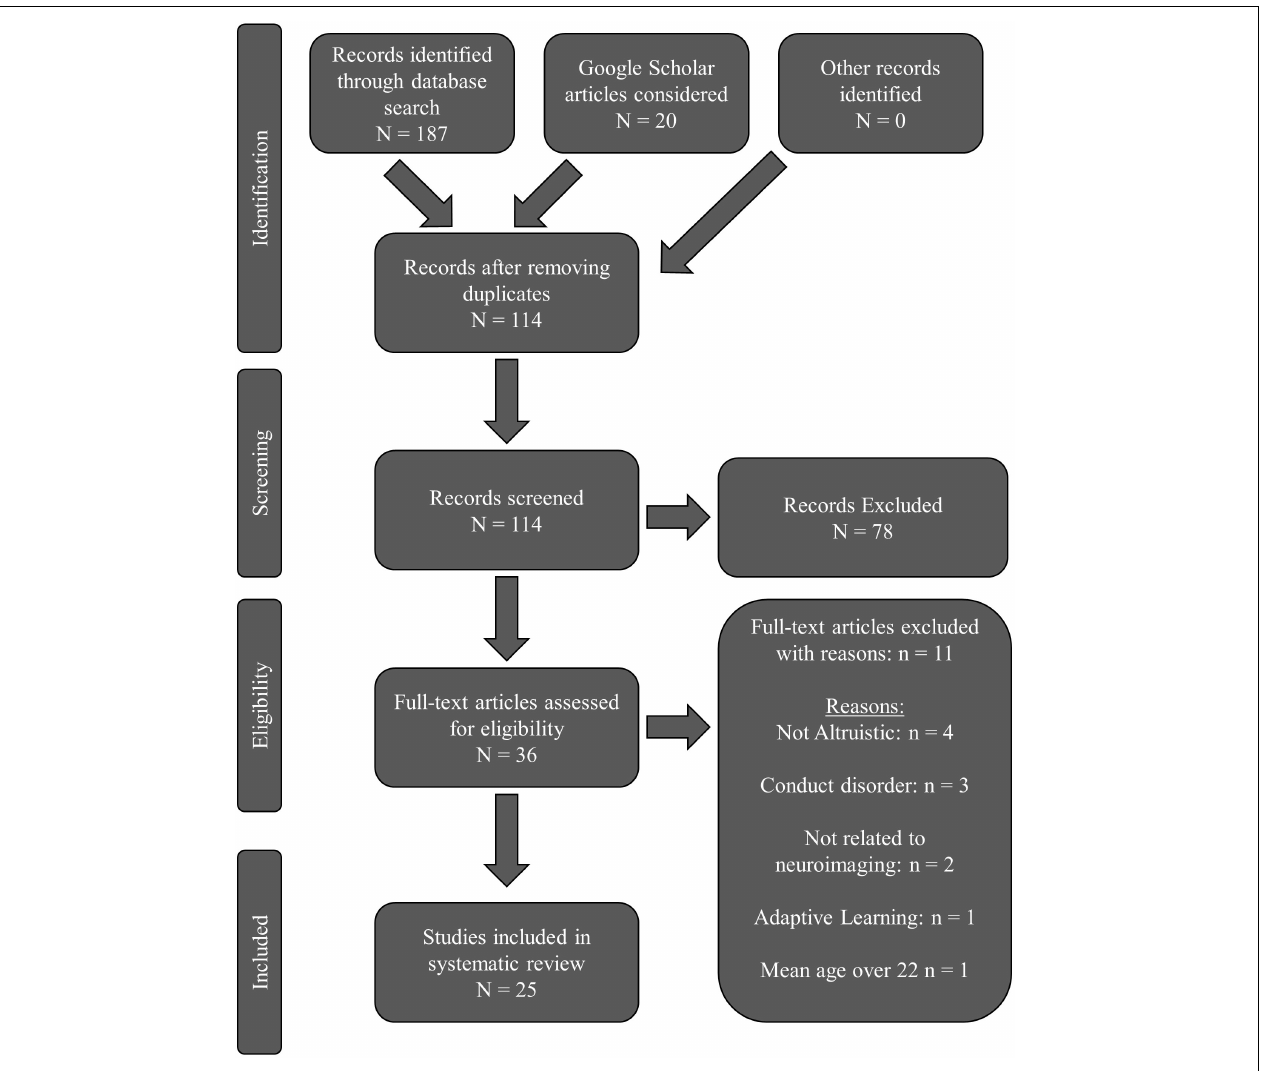
FIGURE 1 | PRISMA flow chart for the systematic review literature